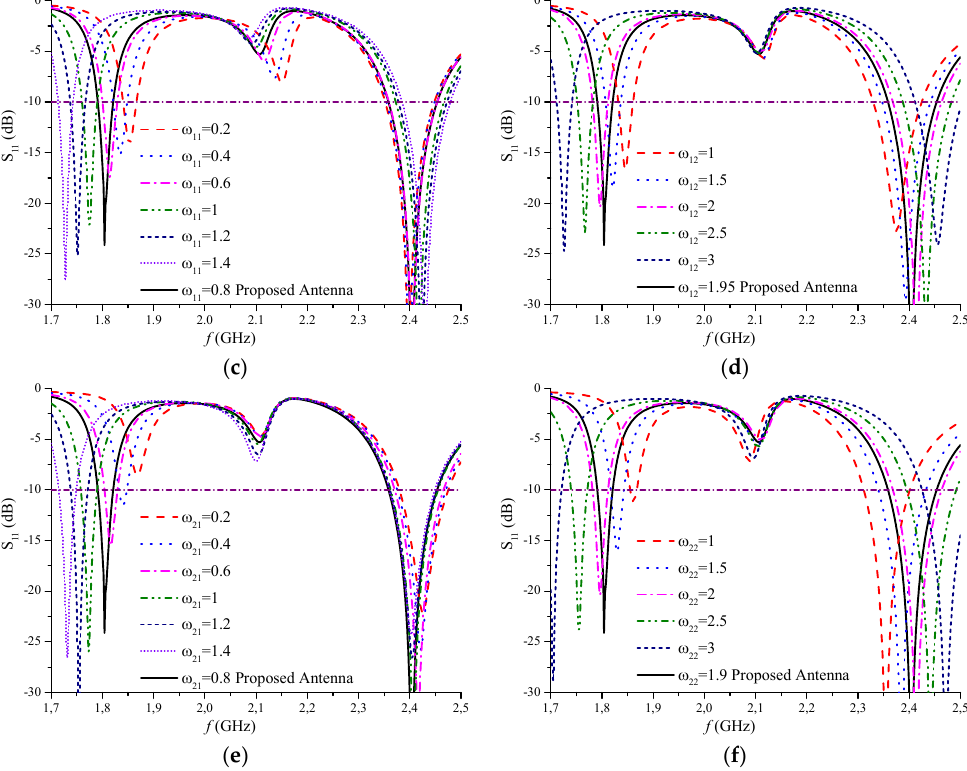
Figure 8. Effect of arcs thicknesses on S 11 of the proposed antenna: ( a ) inner radius of the first arc r 1 ; ( b ) inner radius of the second arc r 2 ; ( c ) w 11 thickness of the first arc; ( d ) w 12 spacing between ground plane and first arc; ( e ) w 21 spacing between ground plane and second arc; and ( f ) w 22 thickness of the second arc.